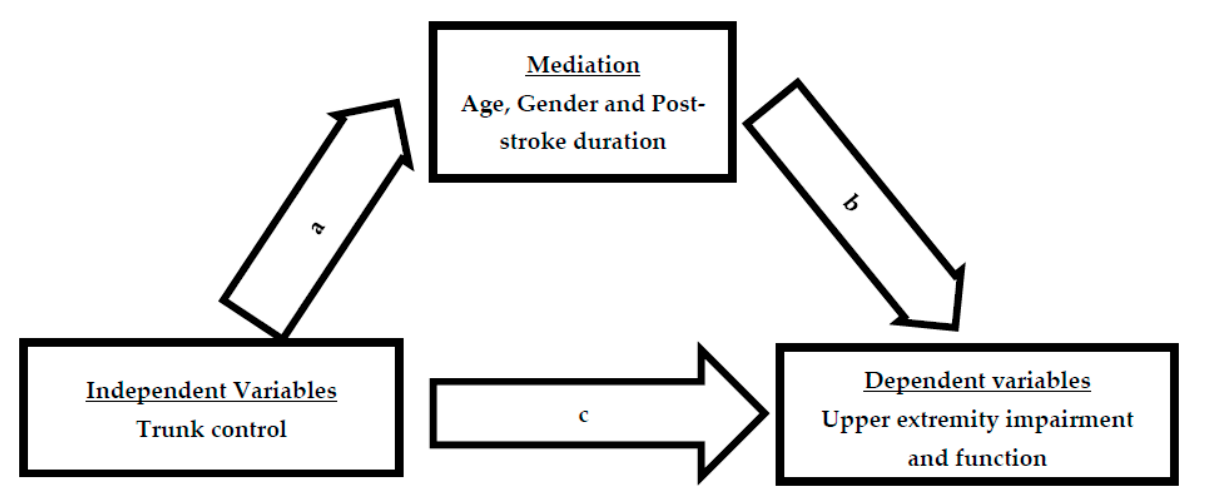
Figure 1. Mediation model including age, gender, and post ‐ stroke duration as control variables.